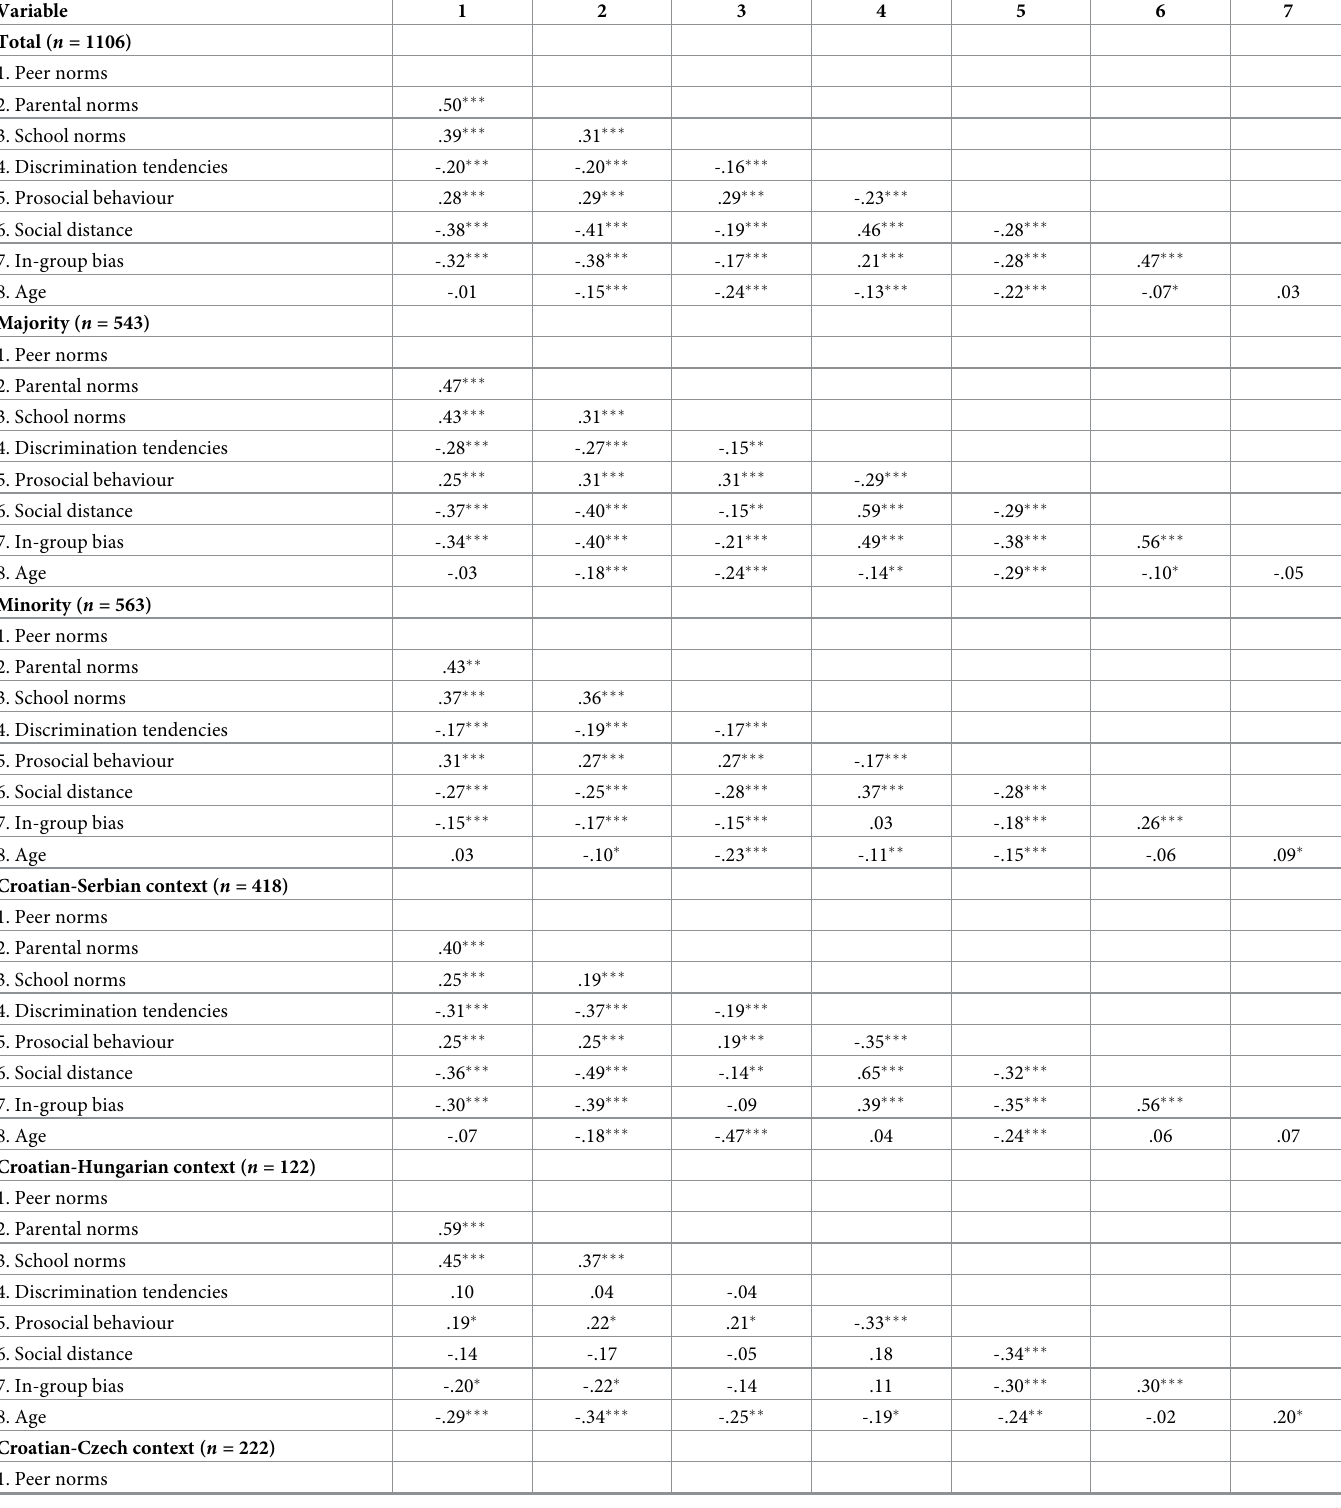
Table 3. Correlations among key study variables for total sample and per status and contextual subgroups.